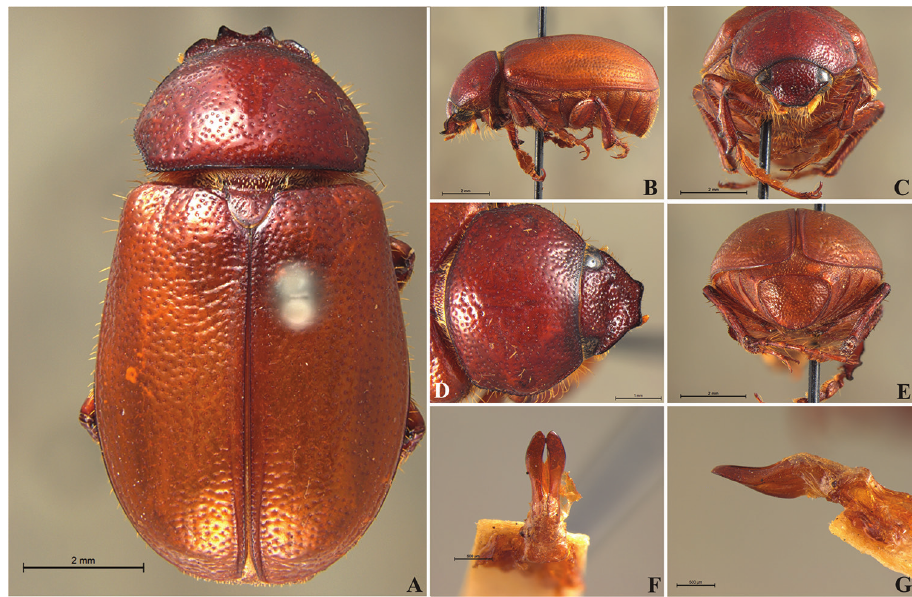
Figure 65. Liogenys laminiceps Moser. A Dorsal view B Lateral view C Frontal view D Clypeus and pronotum E Pygidium F Parameres, dorsal view G Parameres, lateral